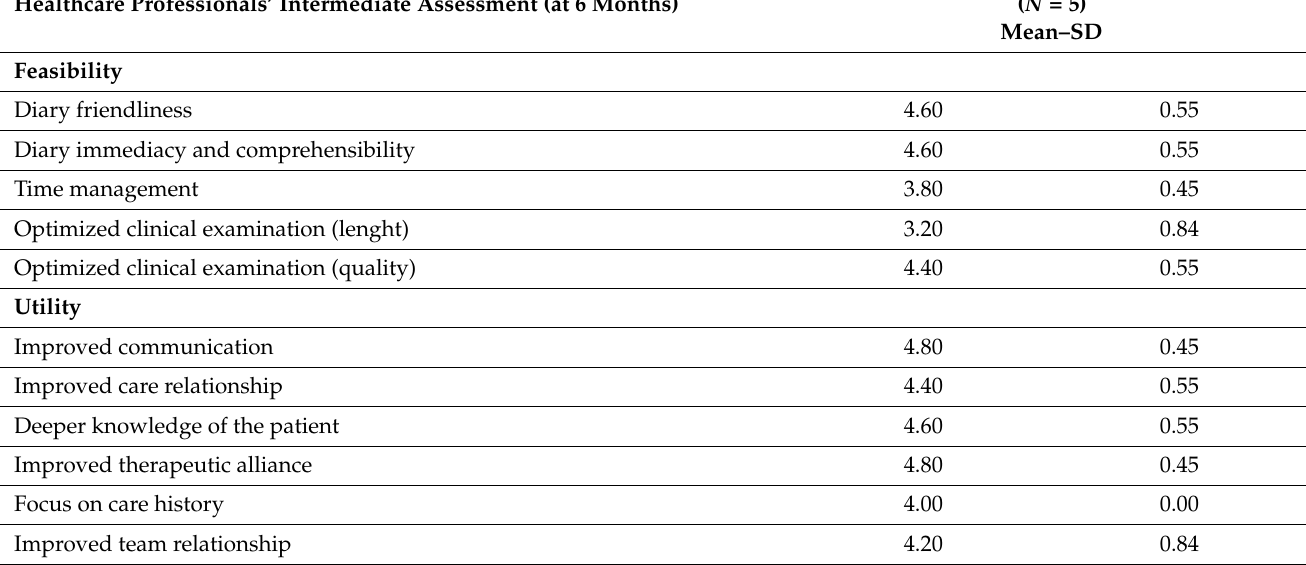
Table 3. Evaluation of the digital narrative diary by healthcare